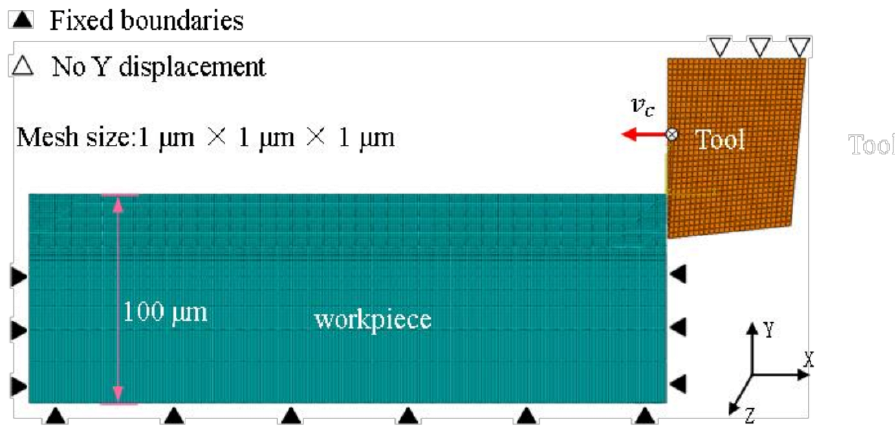
Figure 2. Finite element cutting simulation modeling. Table 2. The physical and mechanical properties of the workpieces [20,21].